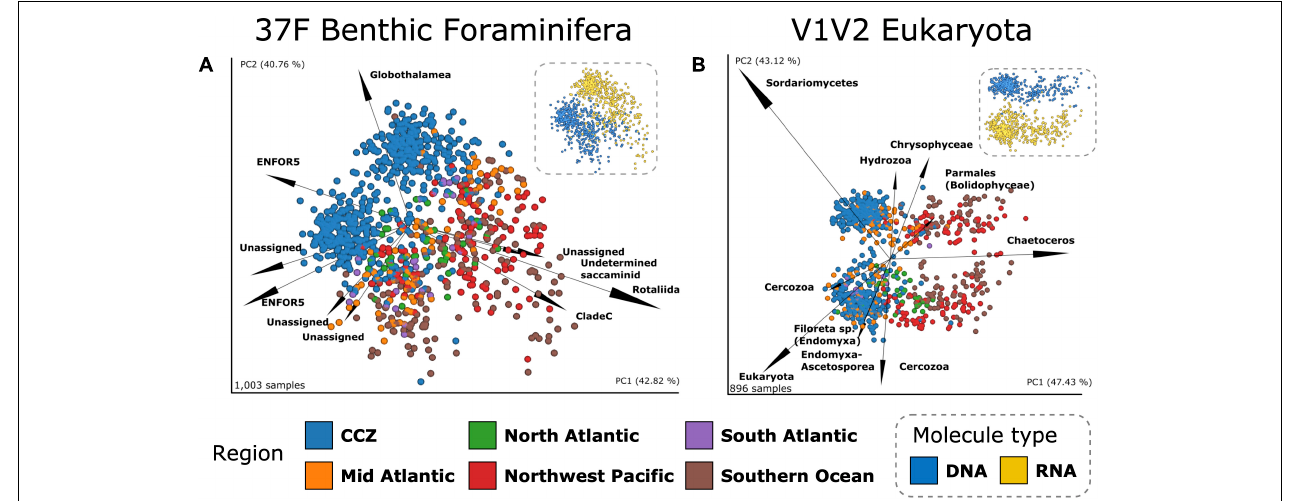
FIGURE 7 | Deep-sea benthic communities beta diversity. Robust PCAs based on the Aitchison metric for (A) the 1,003 37F samples (B) the 896 V1V2 samples. PCR-amplified samples (scatter), are colored according to region and the top 10 most influential OTUs biplots (arrows) are labeled with their deepest taxonomic assignment. Insets represent the same RPCAs but colored according to molecule type. The percentages indicated for PC1 and PC2 are large because they represent the variance explained in the three first